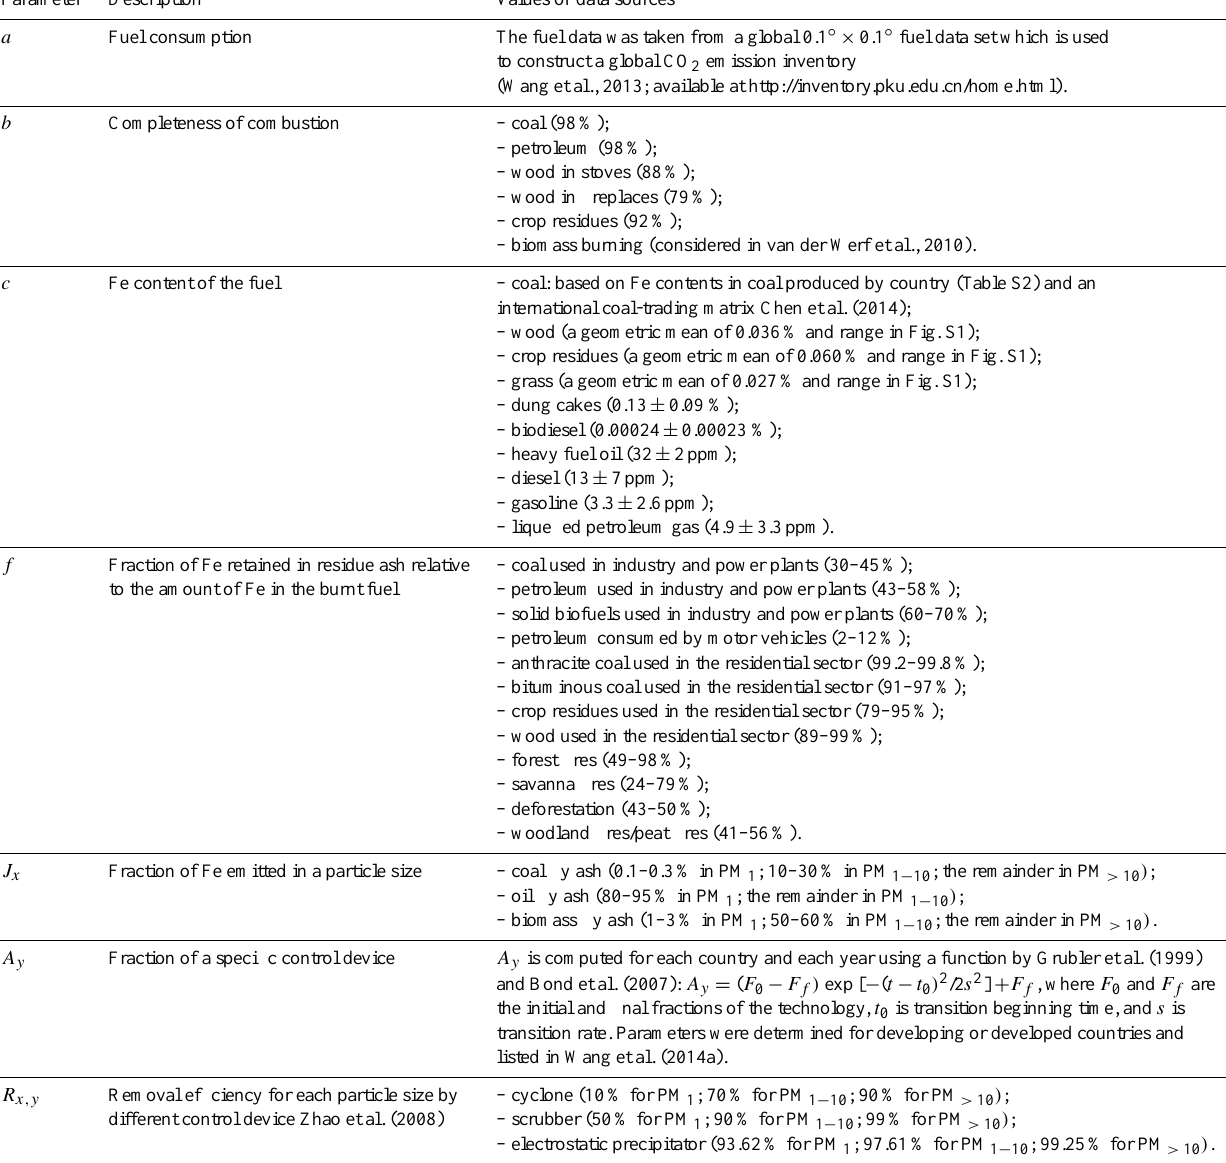
Table 1. Parameters used in the estimation of Fe emissions from combustion